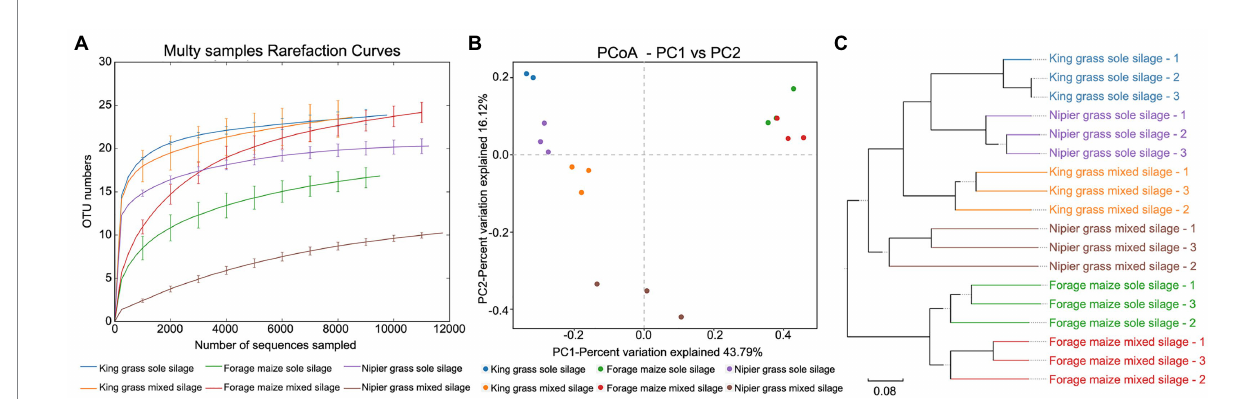
FIGURE 2 Diversity of bacterial communities between sole and mixed silages. (A) Rarefaction curves for α -diversity measures of operational taxonomic units (OTUs) comparing bacteria from sole and mixed silages. Error bars correspond to one standard deviation from the average ( n = 3 biological replicates). (B) Unconstrained principal coordinates analysis (PCoA) (for principal coordinates PCo1 and PCo2) with weighted UniFrac distance showing that bacteria in different samples separate in the first axis ( p < 0.001, PERMANOVA). (C) Hierarchical clustering trees in unweighted pairwise average method (UPGMA) analysis. Distance matrices were obtained using the weighted UniFrac distance algorithm. The samples that are closer (with shorter branch length) share higher similarity in species